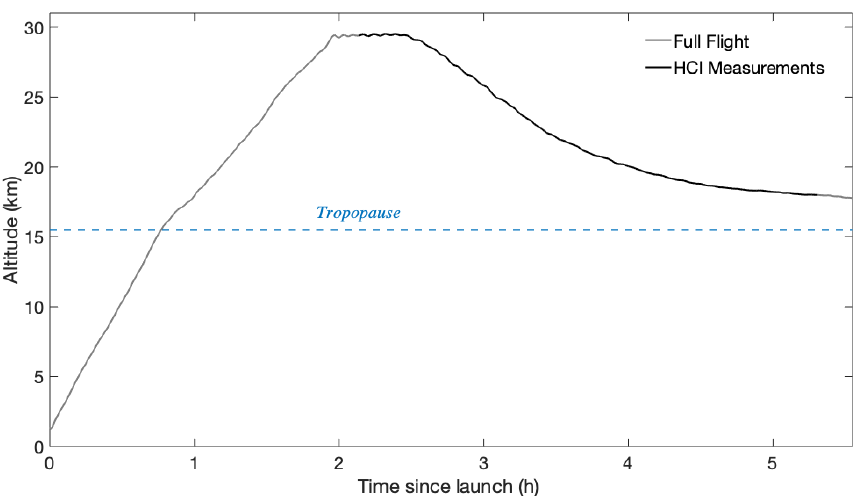
Figure 8. The full altitude profile of the HUSCE flight is shown in grey. The black segment of the profile is when the HCl instrument was on and recording measurements. The tropopause is determined by the observed reversal in lapse rate from the ambient temperature sensor on the gondola.